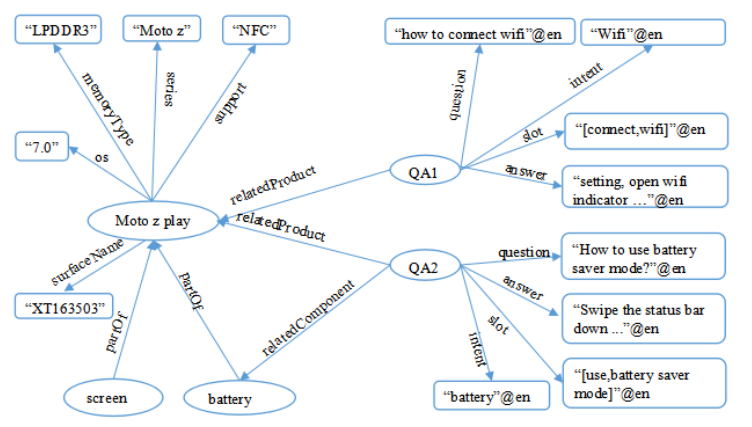
Figure 5. Structure of the product-knowledge base (KB) and question-answer